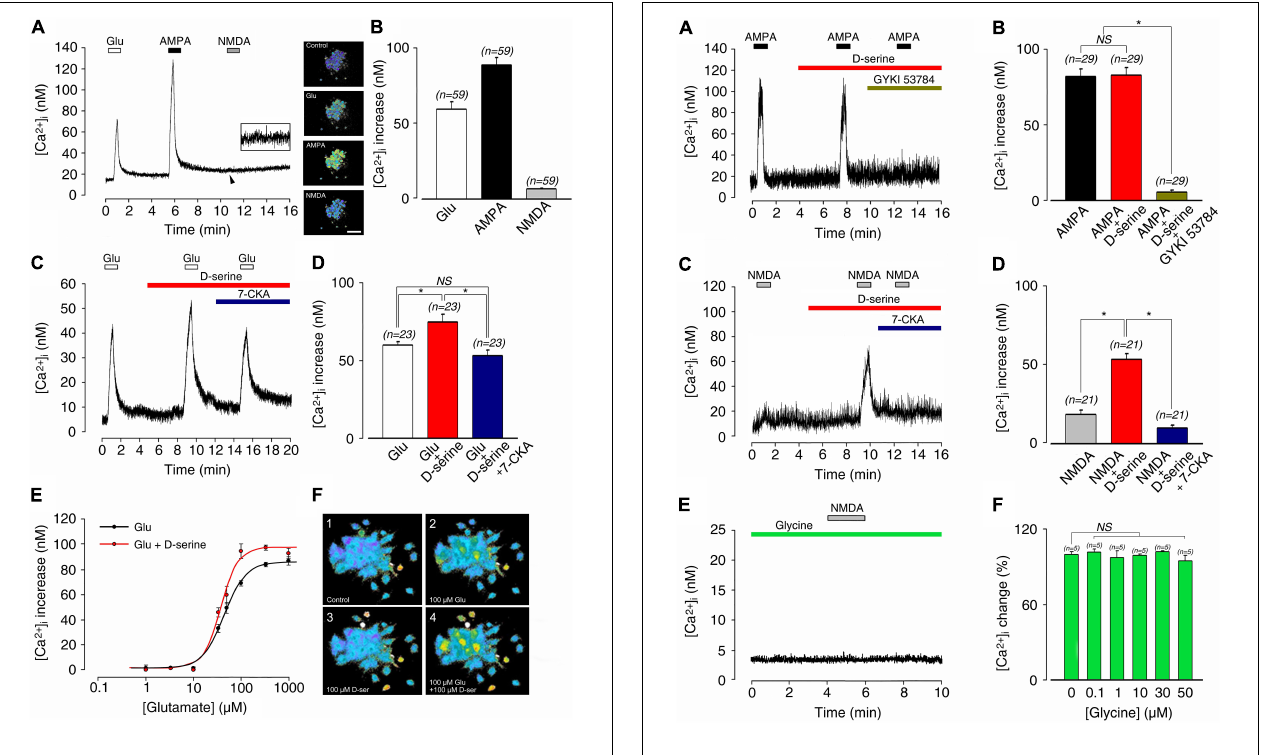
FIGURE 6 | D -serine and not glycine enabled NMDA-induced [Ca 2 + ] i responses on postnatal 1–4-day rat SGNs. (A) AMPA-induced [Ca 2 + ] i increases (100 µ M; n = 29) were unaffected by the presence of 100 µ M D -serine ( n = 29). The pharmacological specificity of the AMPAR stimulation was verified by using the selective stereoisomer AMPAR antagonist GYKI 53784 (40 µ M; n = 29). (B) Histograms summarizing changes in [Ca 2 + ] i after a sequential stimulation with 100 µ M AMPA alone ( n = 29), 100 µ M AMPA plus 100 µ M D -serine ( n = 29), and in the presence of GYKI 53784 ( n = 29). (C) Co-application of 100 µ M D -serine with 100 µ M NMDA unmasked a large [Ca 2 + ] i increase, leading to an increase of 540% compared to NMDA alone ( n = 21). Pharmacological blockade of the D -serine excitatory effect was suppressed by using the selective NMDAR antagonist 7-CKA (50 µ M; n = 21). (D) Histograms summarizing changes in [Ca 2 + ] i after a sequential stimulation with 100 µ M NMDA alone ( n = 21), 100 µ M NMDA plus 100 µ M D -serine ( n = 23), and in the presence of 7-CKA (50 µ M; n = 23). *( p < 0.05). (E) 100 µ M NMDA in the presence of 20 µ M glycine did not elicit any response or basal [Ca 2 + ] i changes ( n = 28). (F) Increasing concentrations of glycine (0.1, 1, 10, 30, 50 µ M) did not change basal [Ca 2 + ] i ( n = 25) in SGN somata compare to the control condition. (n) number of neurons, *( p < 0.05), (NS) (not